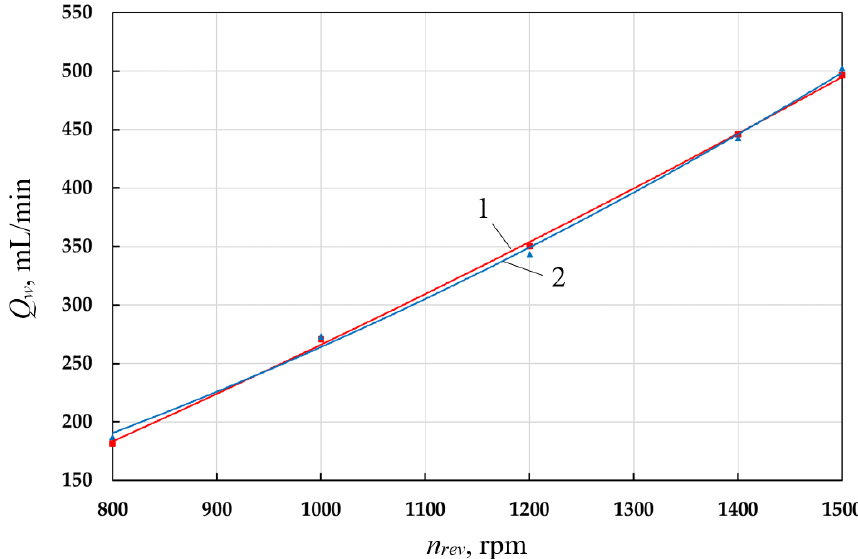
Figure 15. Dependence of the volumetric flow rate of the coolant of the left (1 — Q w1 ) and right (2 —